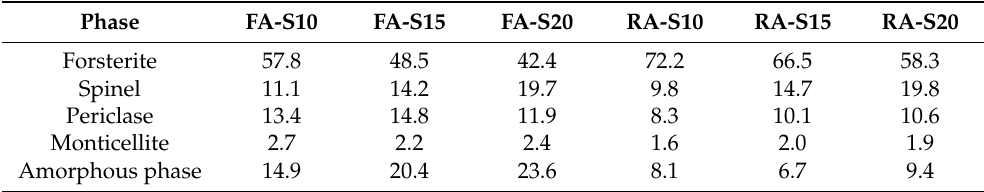
Table 3. Quantitative phase composition of all mixtures.